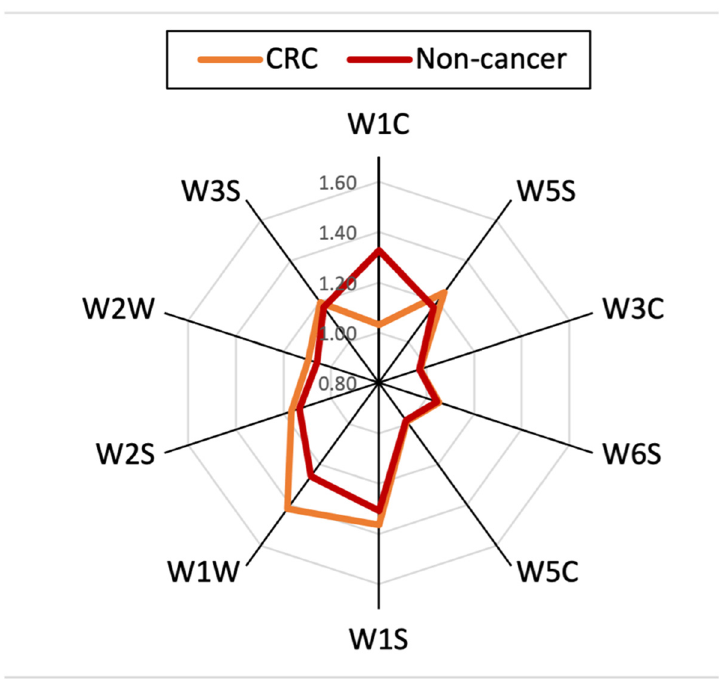
Figure 3. Radar plot of the output features of the PEN3 to a CRC and control sample. Radar plot in Figure 4 shows the average response of the sensors corresponding to the early-stage CRC (green line), late-stage CRC (orange line), and non-cancer group (red line).